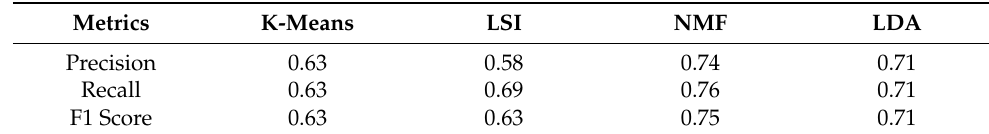
Table 4. Results of the algorithms: K-means, LSI, NMF, LDA.